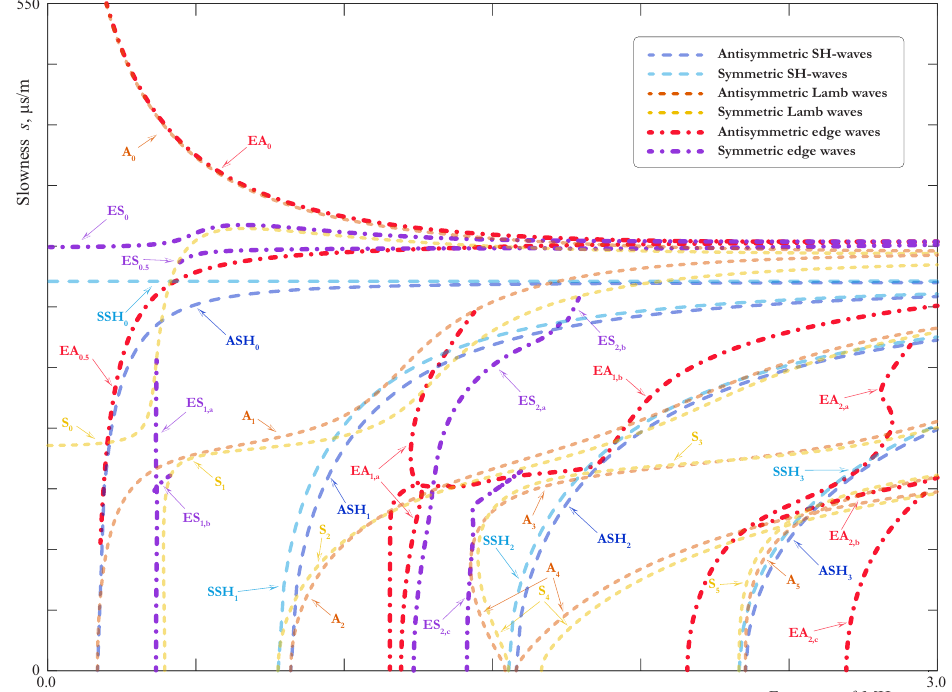
Figure 14. Slownesses of all GWs propagating in 4.05 mm thickness symmetric laminate with a soft thin interlayer (2 mm aluminium/50 µ m film/2 mm aluminium).